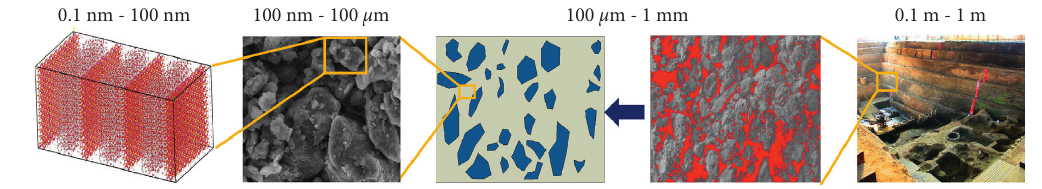
Figure 1: Multiscale structural characteristics of site soil